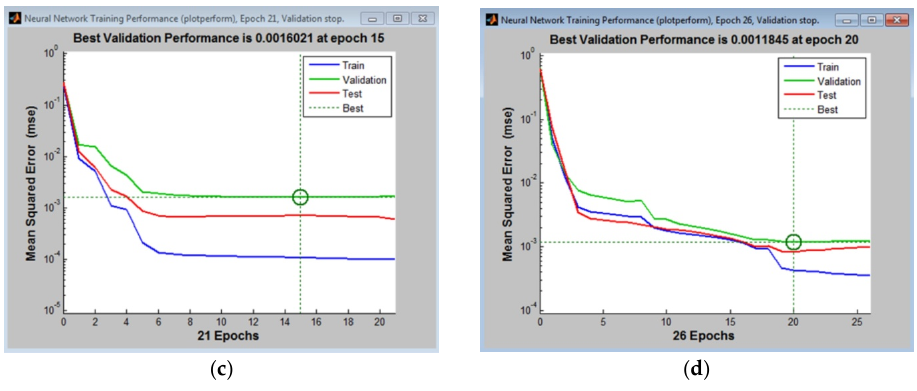
Figure 6. The lowest mean squared error (LMSE) for the validation set in MLP 3-10-4 and the ( a ) ET500; ECAP-2 ( b ); ECAP-4 ( c ); ECAP-6 ( d ) hardening method configuration (calculated in Matlab).